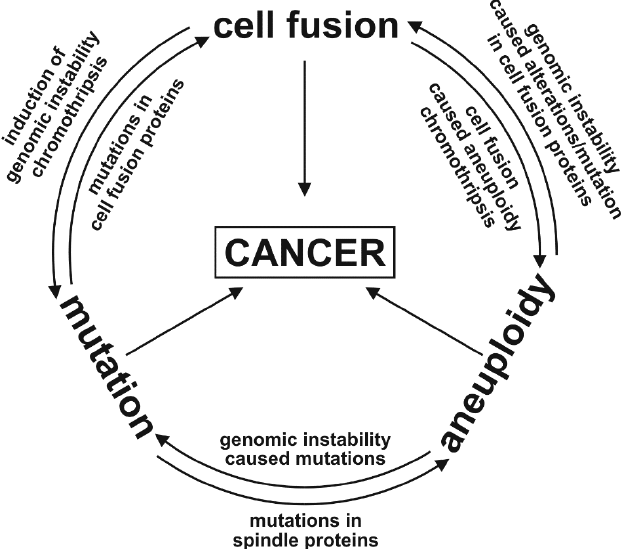
Figure 4. The interrelationship between mutations, aneuploidy and cell fusion as inducers of genomic instability and a mutator phenotype in cancer. instability and a mutator phenotype in